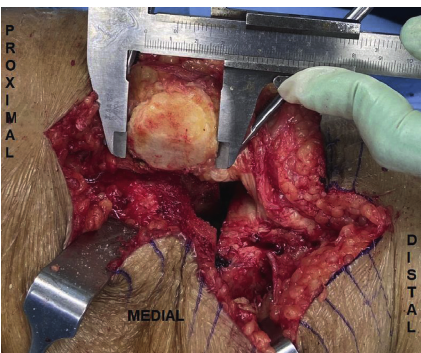
Figure 2: Measurement of left patella’s height using a vernier caliper.